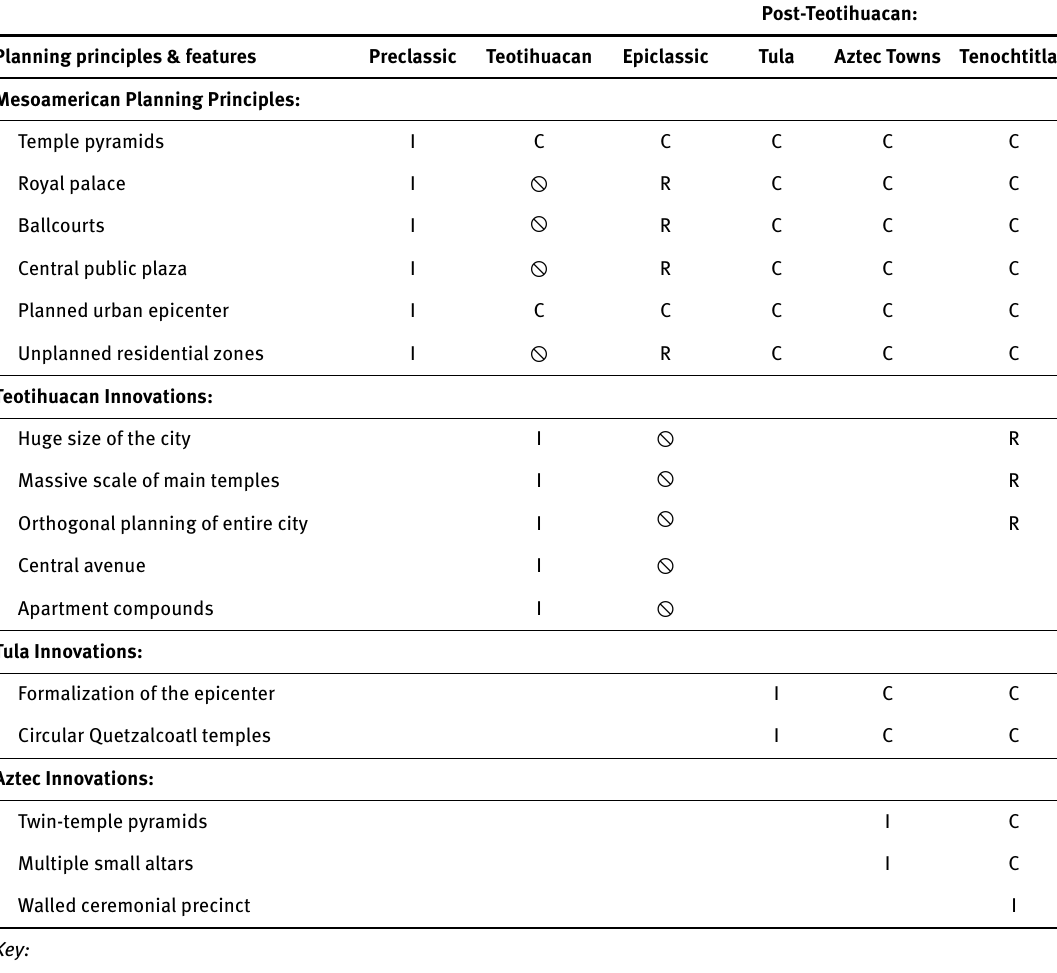
Table 2. Trajectory of urban planning principles in central